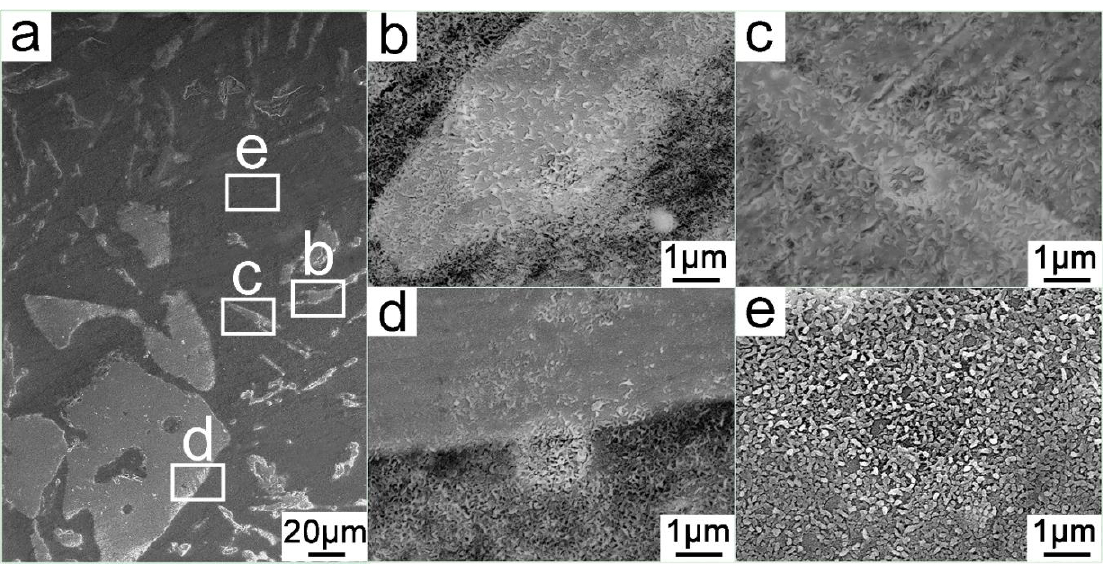
Figure 10. The morphology of the Al-20Si@Al(OH) 3 (W): ( a ) Al-20Si, ( b , c ) eutectic silicon, ( d ) primary silicon, and ( e ) aluminum.